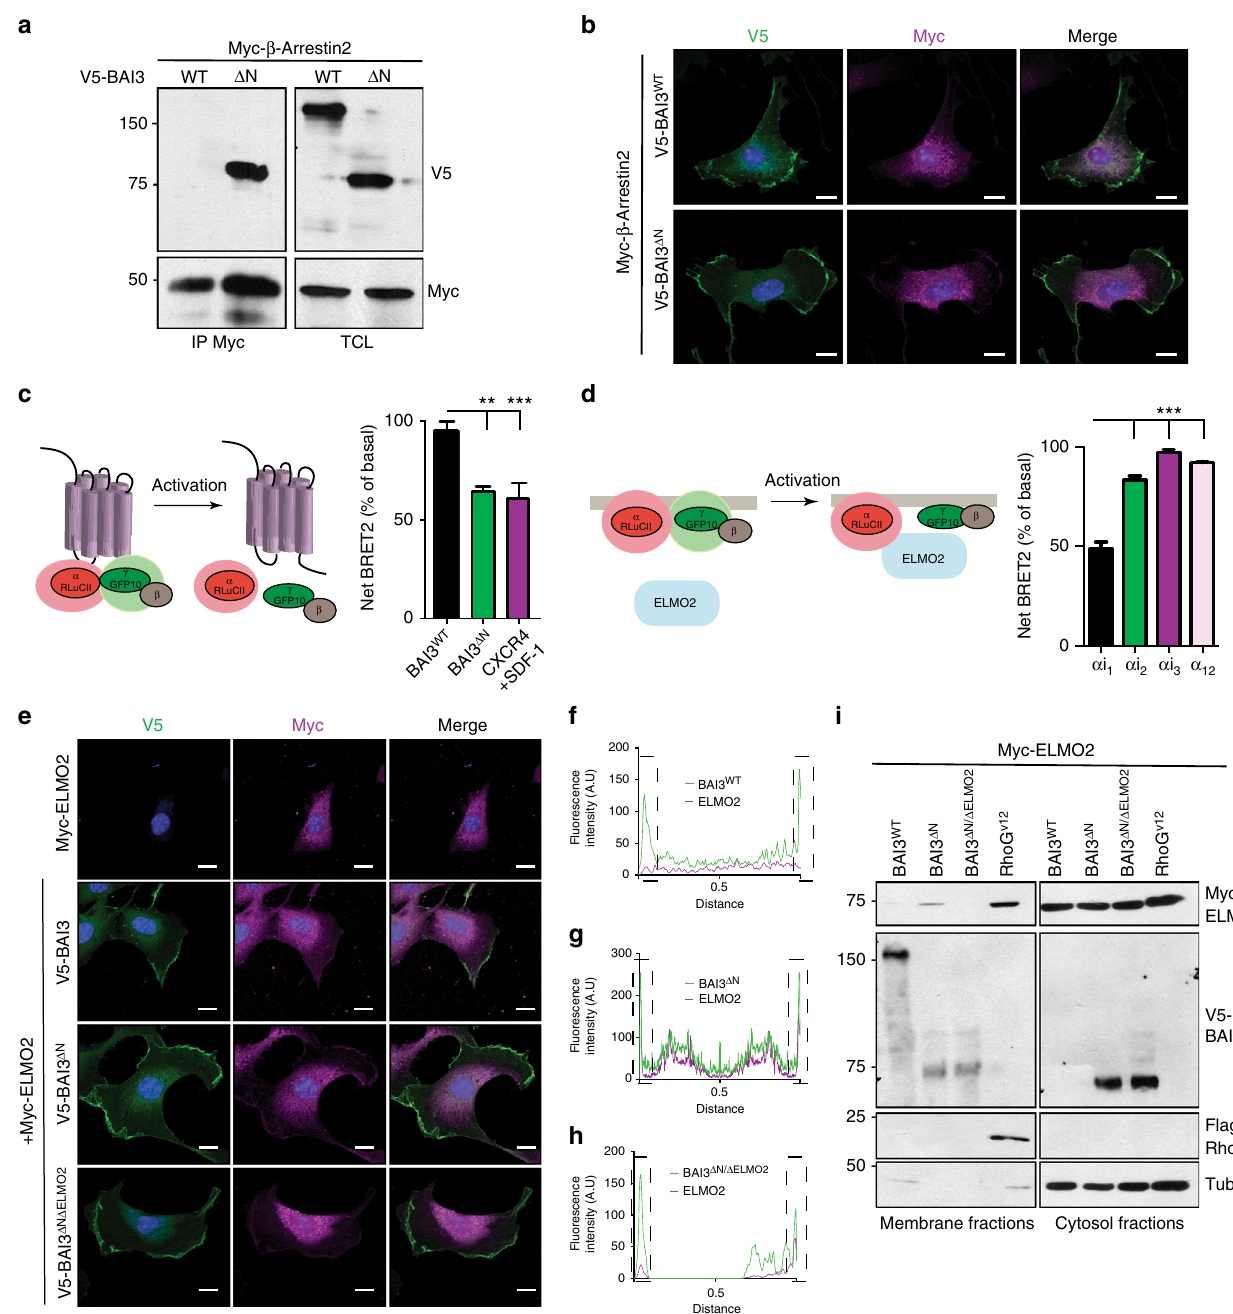
Fig. 7 Canonical and non-canonical signaling from BAI3 are required to promote the recruitment of ELMO at the membrane. a A mutant of BAI3 lacking the extracellular domain (BAI3 Δ N ) robustly interacts with β -Arrestin2. Immunoprecipitations of Myc- β -Arrestin2 revealed an interaction with Flag-BAI3 Δ N but not with Flag-BAI3 WT . b Immuno fl uorescence experiments assessing the ability of BAI3 WT or BAI3 Δ N (green) to recruit Myc- β -Arrestin2 (purple) at the membrane of C2C12 cells. c Effect of BAI3 WT and BAI3 Δ N on BRET2 signal between G proteins G α i1 -RlucII and GFP10-G γ 2 in cells co-transfected with the untagged G β . d Effect of ELMO2 on the BRET2 signal between G proteins G α i1 -RlucII and GFP10-G γ 2 in cells co-transfected with the untagged G β . Net BRET2 signal is normalized to basal BRET2 signal. e – h . BAI3 Δ N promotes the recruitment of ELMO2 at the membrane in C2C12 cells. e Immuno fl uorescence assessing ELMO2 (purple) recruitment at the membrane in the presence of either Flag – tagged BAI3 WT , Flag-BAI3 Δ N or BAI3 Δ N/ Δ ELMO2 (green). f – h Quanti fi cation of experiment shown in e . i Membrane fractionation experiments of HEK293T cells followed by western blot analyses demonstrate the ability of BAI3 Δ N to recruit ELMO2 at the membrane. Error bars indicate standard deviation. Scale bar = 100 μ m. One-way ANOVA followed by a Bonferroni test was used to calculate the P- values; ** P < 0.01, *** P <